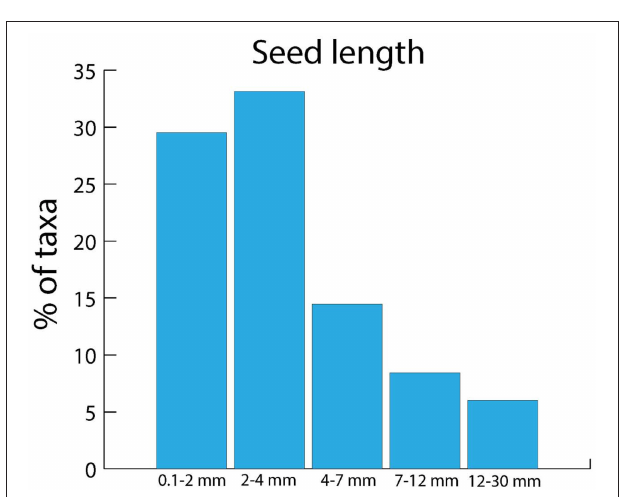
Frontiers in Ecology and Evolution |